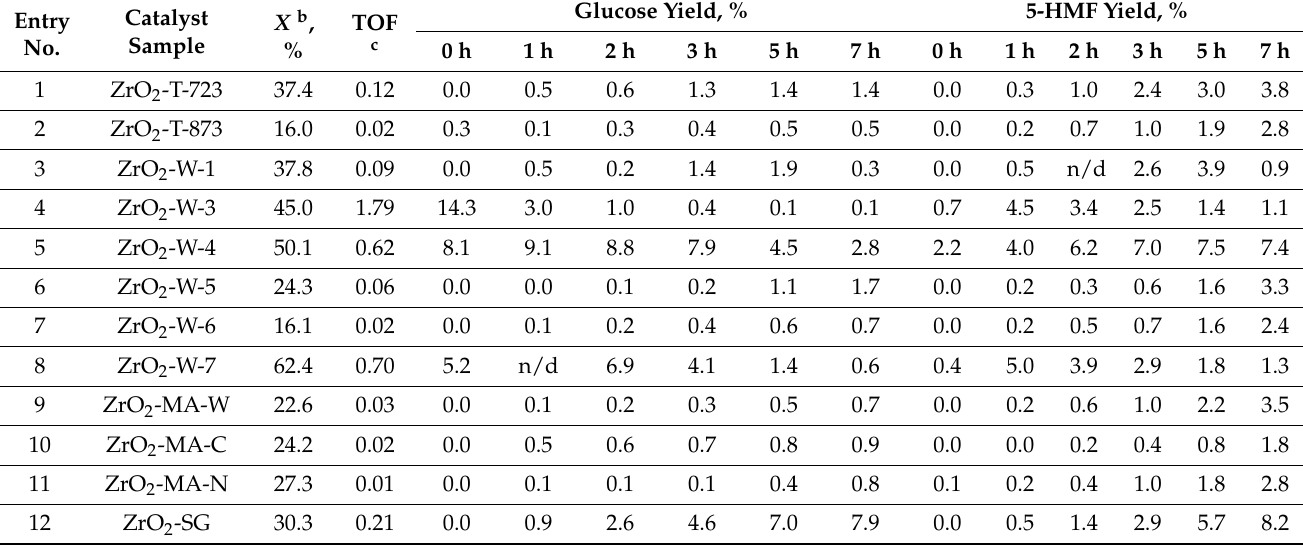
Ar 1 MPa, 1000 rpm, reaction